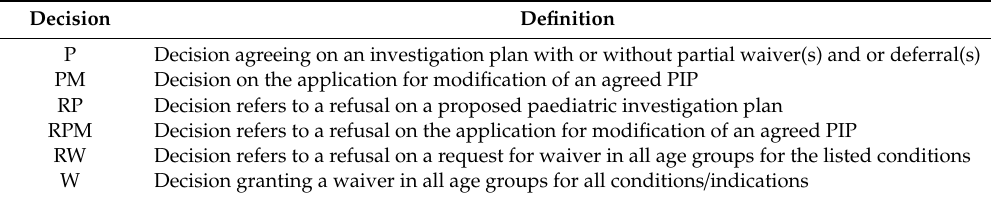
Table 1. Decisions that the Paediatric Committee (PDCO) can take in response to a pharmaceutical company’s request as defined by the EMA [7]. P and PM are normally referred to as “positive decisions” or “positive PIPs”.